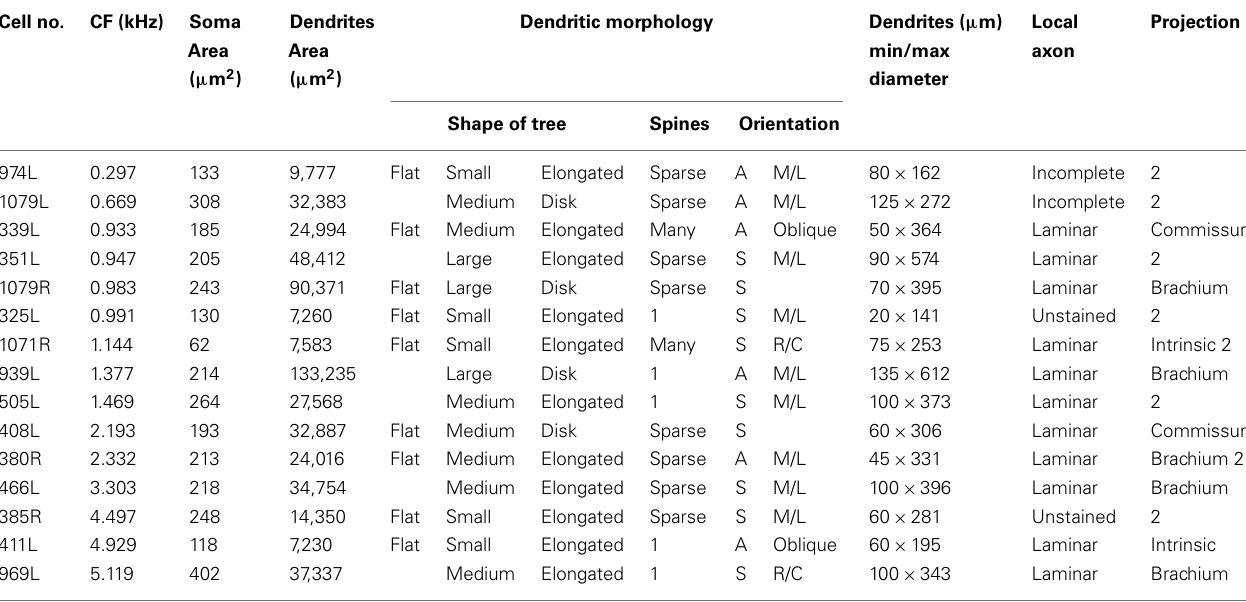
Table 1 | Morphological characteristics of the 15 filled cells. Cell no.